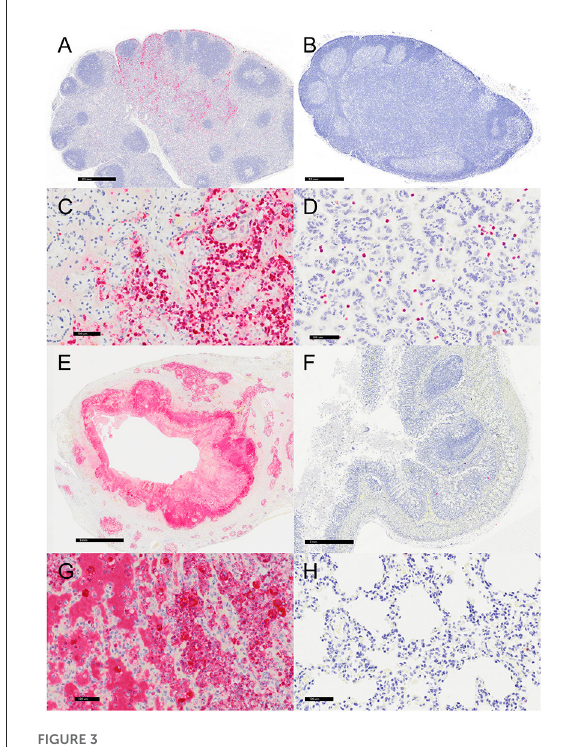
FIGURE3 Immunohistochemistry for myeloperoxidase (MPO)-positive neutrophils, vervets, multiple organs. (A) Y. enterocolitica- positive vervet, mesenteric lymph node, case 6. Neutrophils are present within the medullary sinus of a mesenteric lymph node adjacent to the affected colon. (B) Control vervet, mesenteric lymph node. Neutrophils are rarely observed within the control lymph node. (C) Y. enterocolitica- positive vervet, placenta, case 20. MPO-positive neutrophils are abundant within areas of placental necrosis. (D) Control vervet, placenta. Few neutrophils are present within the placenta, and often associated with physiologically normal areas of coagulative necrosis and mineral. (E) Y. enterocolitica- positive vervet, colon, case 3. MPO-positive neutrophils are prominent within mucosal lesions. Neutrophils are also present within veins and lymphatic vessels of the muscularis mucosa. (F) Control vervet, colon. Neutrophils within the control colon are rare and mainly within the lamina propria. (G) Y. enterocolitica- positive vervet, lung, case 1. Extravasated neutrophils are abundant within lesions of the lung. (H) Control vervet, lung. MPO-positive neutrophils are present only within blood vessels of the control lung.